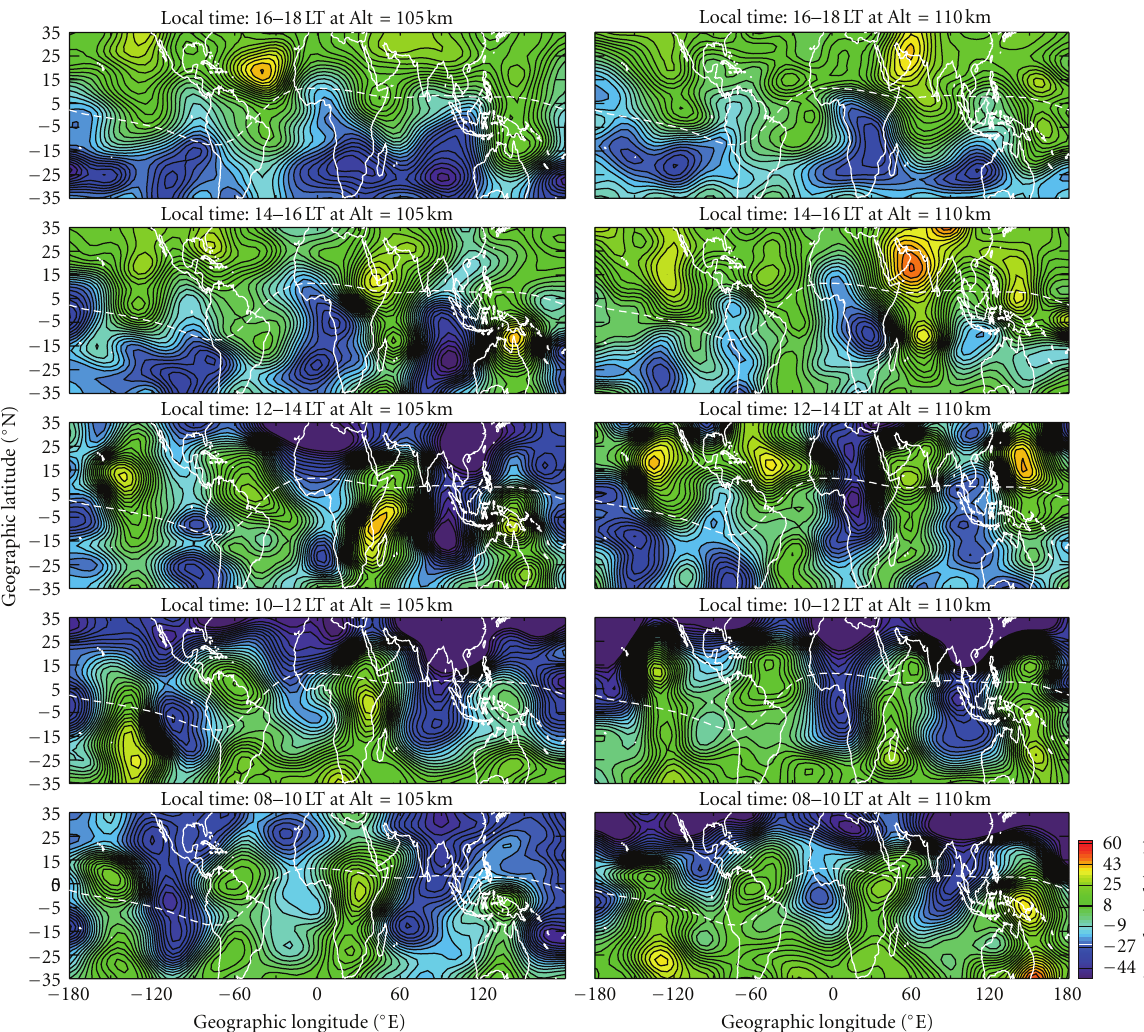
Figure 2: The 60-day data average, into 5 ◦ longitude × 2.5 ◦ latitude bins, of the quiet periods ( K p ≤ 3) zonal wind component observed by TIDI instrument onboard TIMED satellite at 105km (left panels) and 110 km (right panels) altitudes in July and August 2008. Each panel represents di ff erent two-hour local time sector which is given at the top of each panel. The positive and negative components represent eastward and westward wind direction,